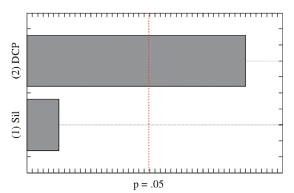
Figure 7. Pareto diagrams: Effect of variables: the amount of filler and DCP concentrations on the response variable Tan delta 2 in silica.